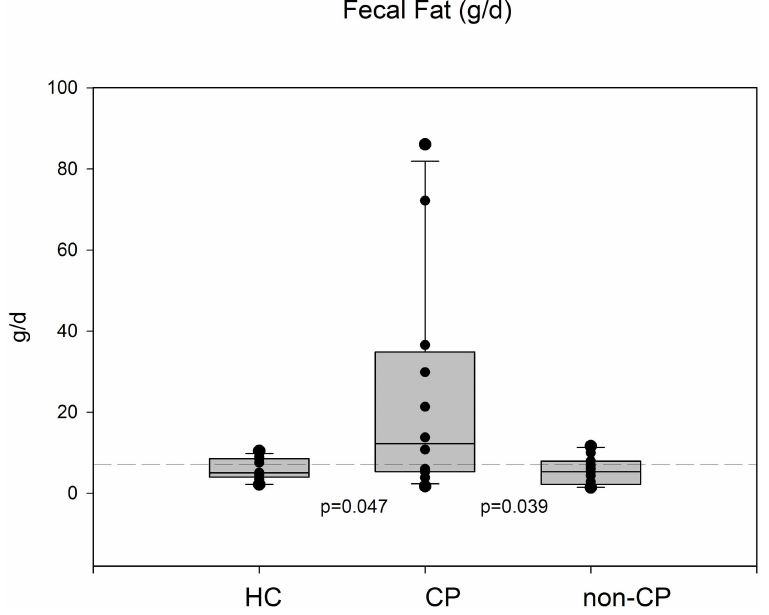
Fig 5. Daily fat output (fecal fat g/d) in median and interquartile range. Cut off after definition in the literature7 gram per day (dashedline). Significantdifference betweenHC/ CP and non-CP/CP. CP patients have pathologicdaily fat